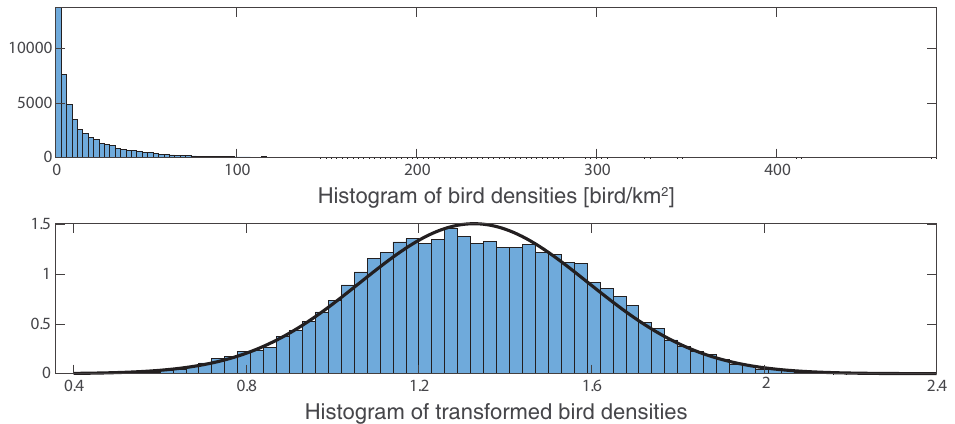
Figure A2. Histogram of the raw bird densities data B ( top ) and the power transformed bird densities B p for the calibrated parameter p = 1/7.5 ( bottom